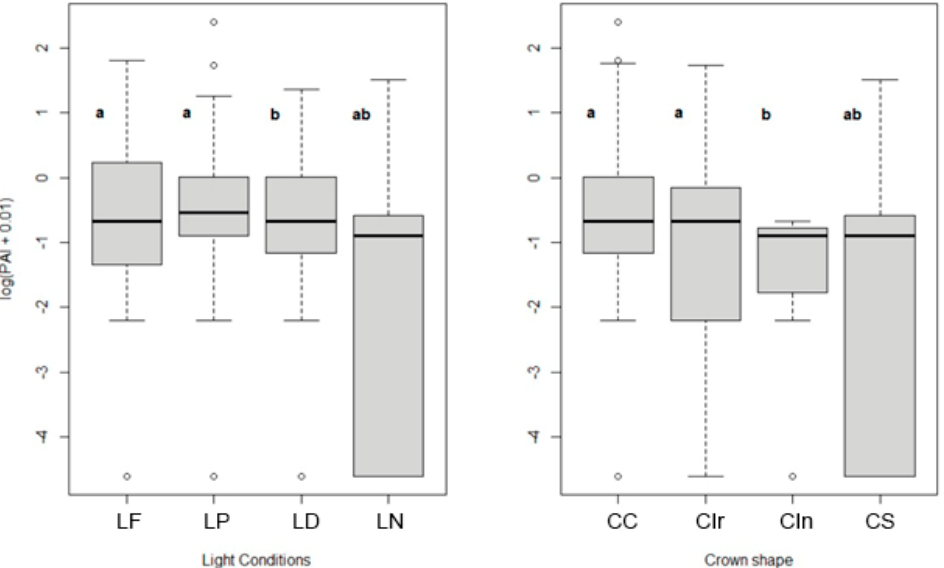
Figure 3. Generalized Linear Model analysis for light exposure, crown shape, and presence of lianas in PAI for individuals ≥ 32 cm of DBH in the ODF. LF—crown receiving full light; LP—crown with partial vertical light, covered by the crown of nearby trees; LD—crown with some side or diffuse light and covered by nearby trees; LN—not evaluated/ no crown. Crown shape was recorded as CC—complete, normal crown; CIr—irregular crown; CIn—incomplete crown; CS—sprouts of trees; CN—no crown. Letters “ a ”, “ b ”, “ ab ” represent statistical differences. The circles represents outlier values.